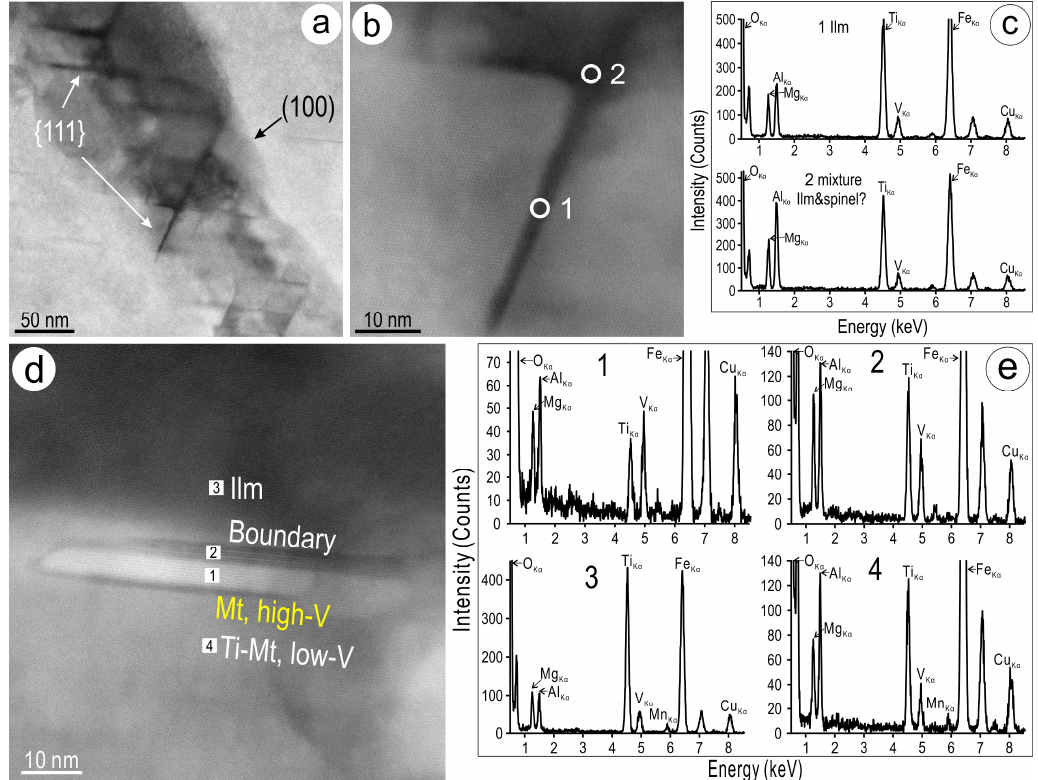
Figure 10. ( a , b ) Low-magnification HAADF STEM images and ( c ) spectra 1 and 2 showing phase association within {111} networks from the edge of titanomagnetite. ( a ) Well-defined lamellar network superimposed onto one of the {100} bands. ( b ) Details from ( a ) showing the junction between two lamellae. ( c ) Spectra 1 and 2 from areas as marked in ( b ) showing ilmenite (top) and Fe-Ti-Mg-(Al)-spinel or a mixture between ilmenite and a spinel mineral (bottom). The Cu peak is due to the TEM grid. ( d ) Low-magnification HAADF STEM image of the bright low-Ti, high-V lamellar magnetite (Mt) at the boundary between titanomagnetite (Ti-Mt) and ilmenite (Ilm). ( e ) STEM EDS spectra taken along a line from titanomagnetite to magnetite and ilmenite (points 1–4), showing variation in V across the assemblage. Note the highest peak is recorded in the bright lamella rather than from titanomagnetite or ilmenite. Additional spectra are shown in Supplementary Materials Figure S6. The Cu peak is due to the TEM grid.